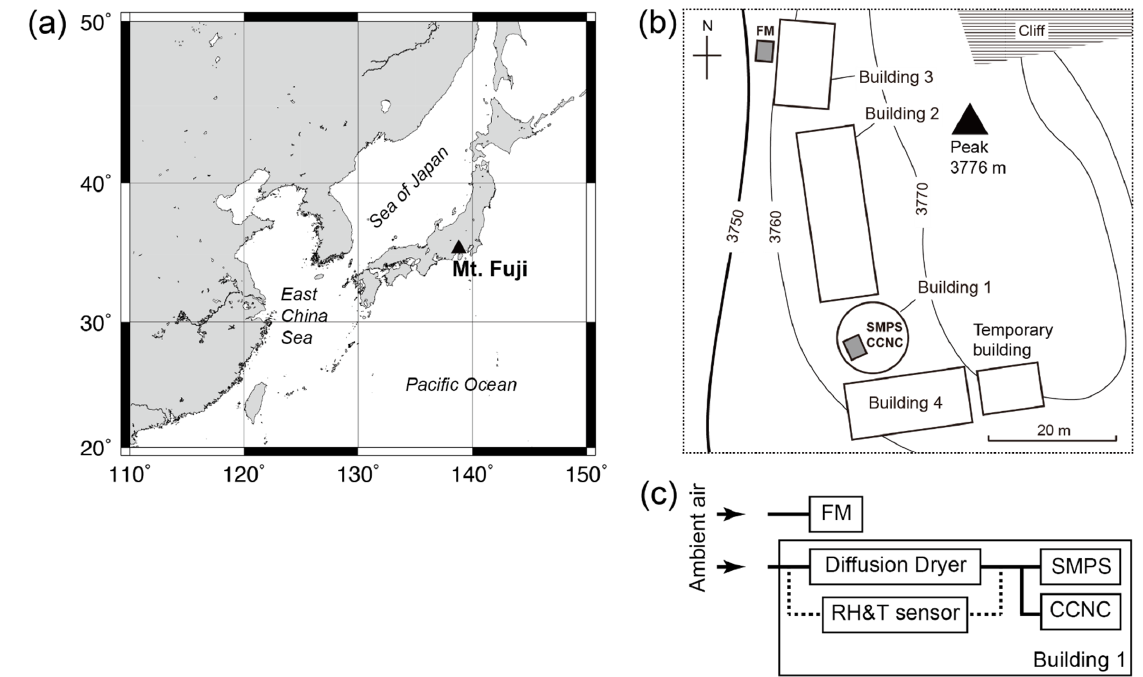
Figure 1. ( a ) Location of Mt. Fuji (altitude 3776 m) in Japan, ( b ) Schematic of the MFRS with locations of the instruments and ( c ) schematic diagram of the instrumentation system in building 1.